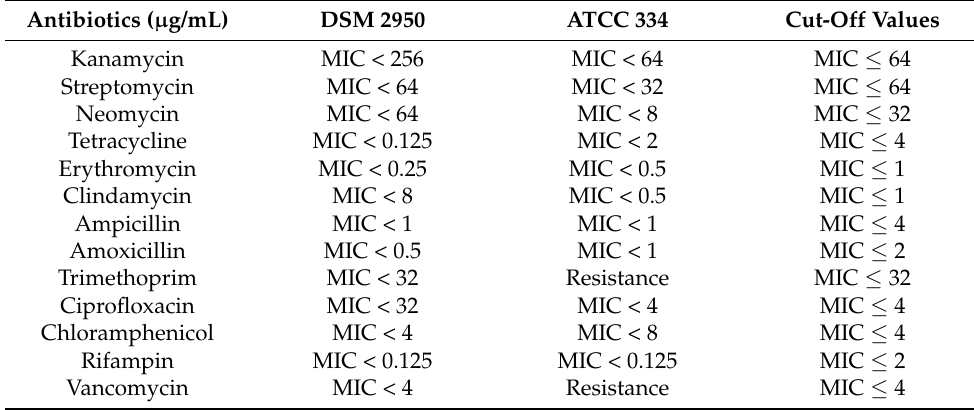
Table 2. Antibiotic susceptibility test of Blautia producta DSM